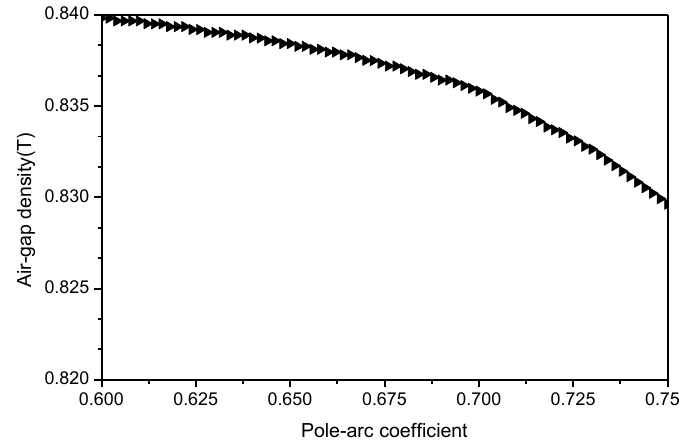
Figure 4. Relation curve between pole-arc coefficient and air-gap density.